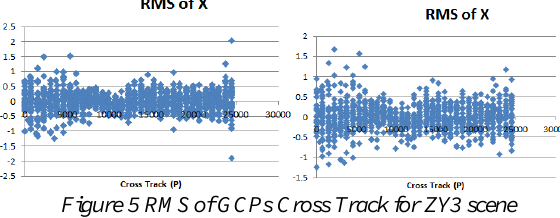
Figure 4 GCP displacement map for scene ZY02C_HR1_E112.4_N34.8_20131107